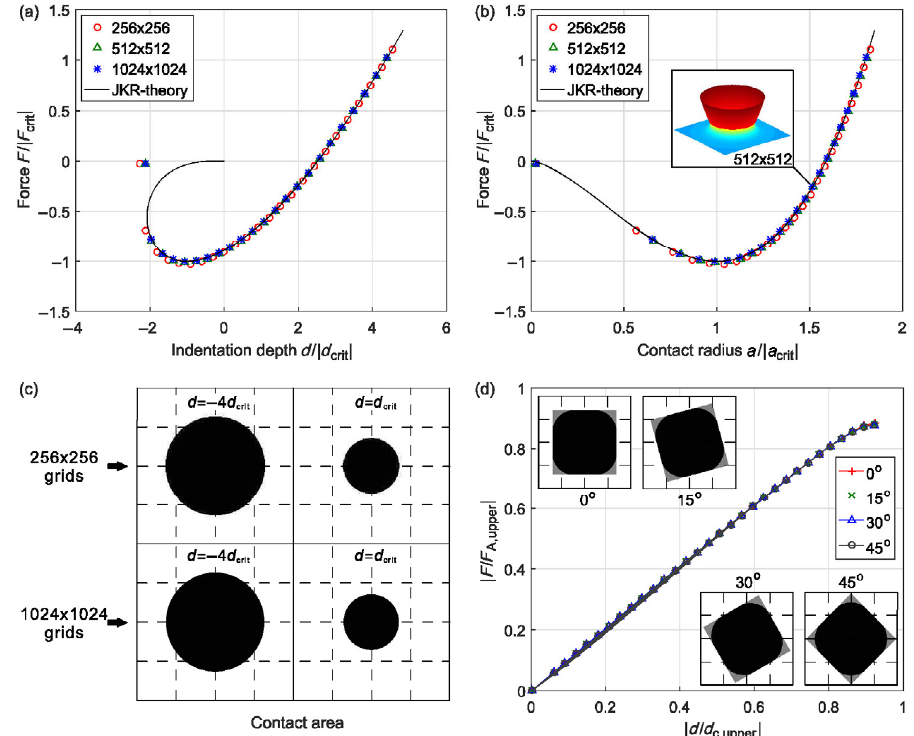
Fig. 3 Comparison of a BEM simulation of the adhesive contact between a parabolic indenter and elastic half-space (JKR-problem) and the analytical solution with (a) force-vs-approach and (b) force-vs-contact-radius relations for three different mesh sizes. (c) Contact areas at four selected approaches illustrating the ideally circular form of contact. (d) Adhesive contact of a square punch in different orientations with 512×512 grid points (dashed lines indicate the orientation of meshing grids), illustrating that neither the contact form not the force-approach-relations do depend on the grid